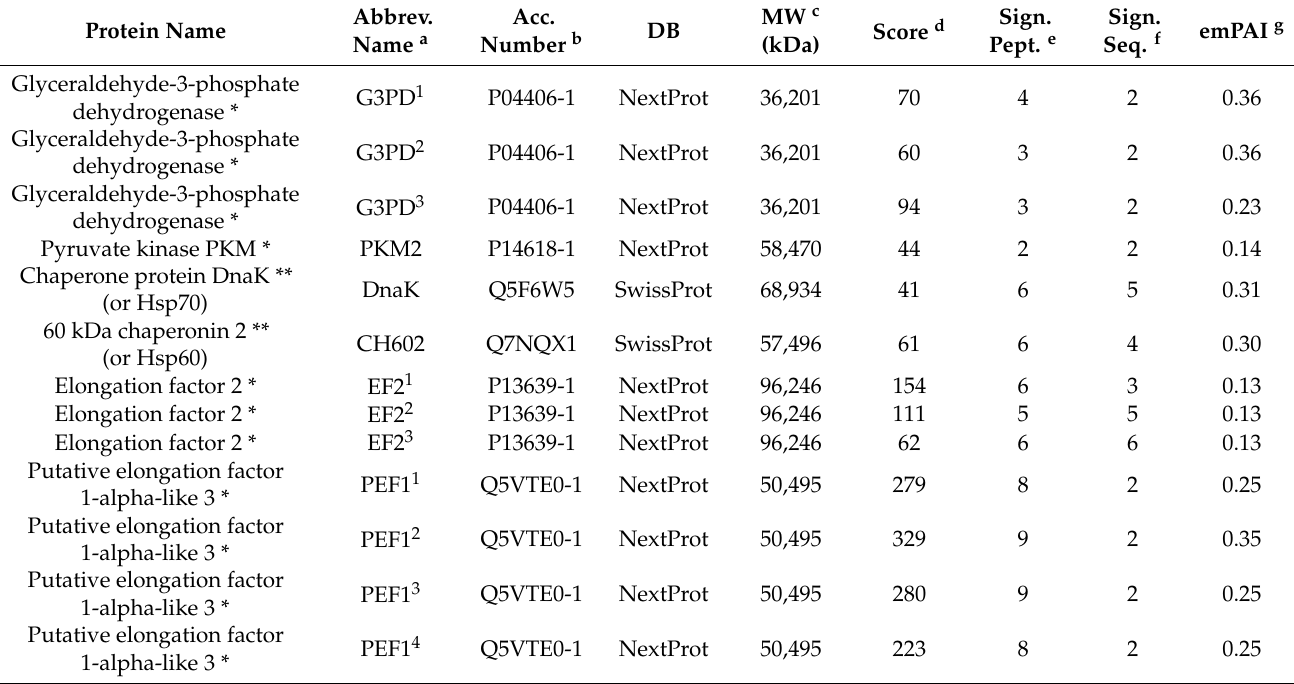
Table 3. Protein identification by